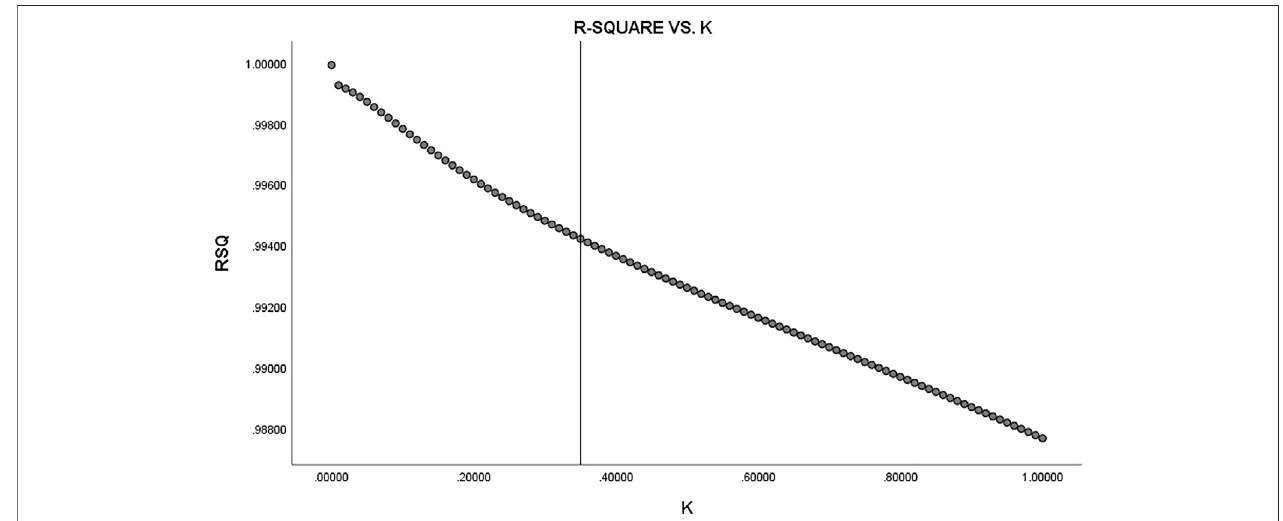
FIGURE 3 | R-square and